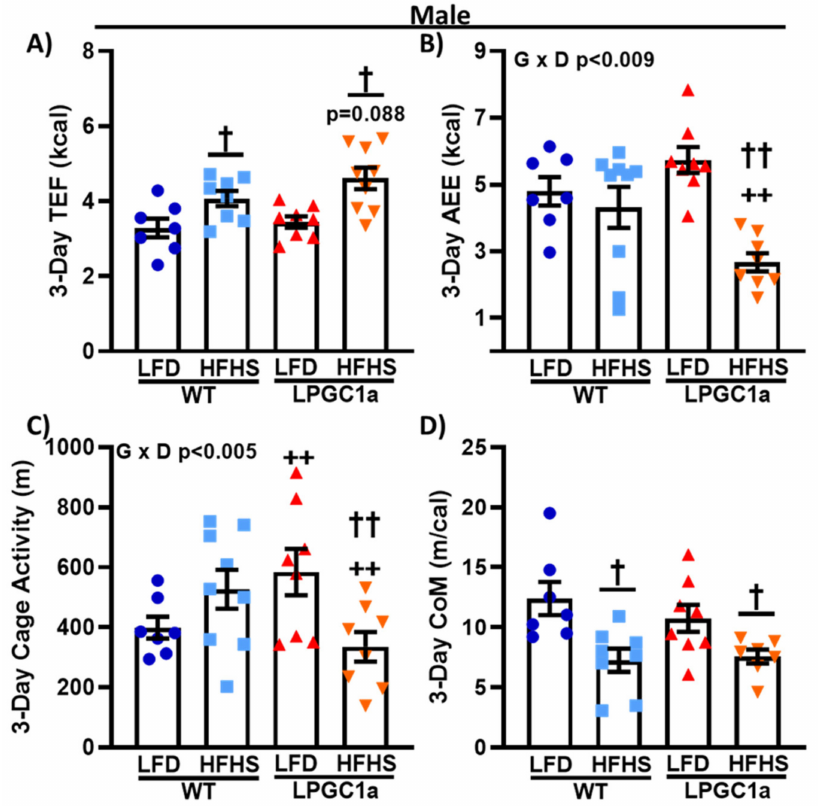
Figure 6. Male LPGC1a mice have lower cage activity and activity EE during short-term HFHS feeding. ( A ) Thermic effect of food was calculated based on the thermic effect of each macronutrient in each diet multiplied by the amount of food intake. ( B ) Activity EE was calculated as the non-resting EE minus the thermic effect of food. Cage activity is represented as total meters traveled (All_Meters, ( C )). The energy efficiency of movement or cost of movement ( D ) was calculated as the activity EE divided by the cage activity. Individual data points and the group means ± SEM are displayed ( n = 7–10). Genotype x Diet p < 0.05 interaction of genotype and diet, † p < 0.05 main effect of diet, †† p < 0.05 LFD vs. HFHS within genotype, ++ p < 0.05 WT vs. LPGC1a within